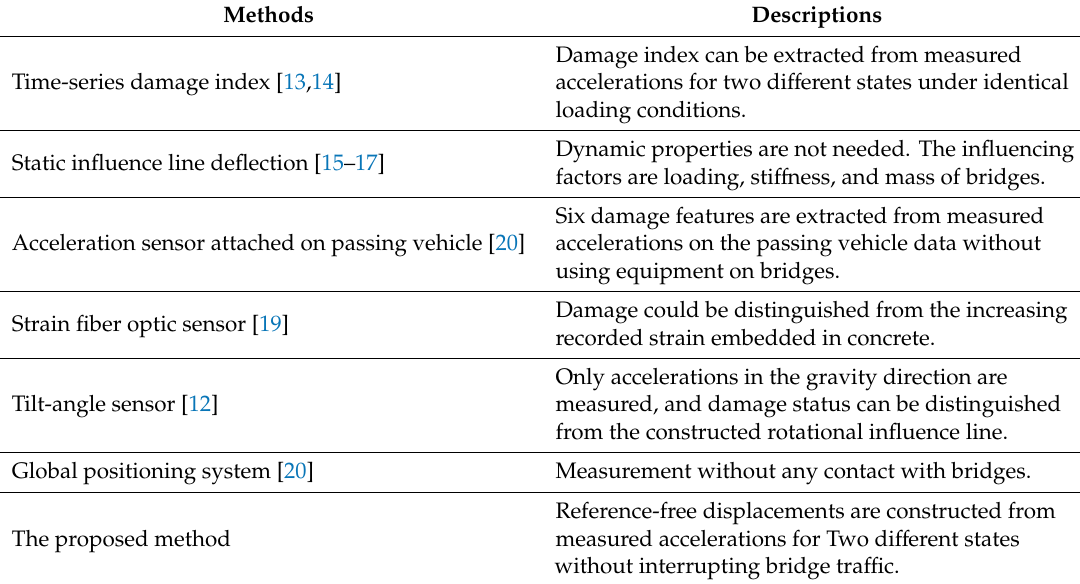
Table 1. Summary of methods in the